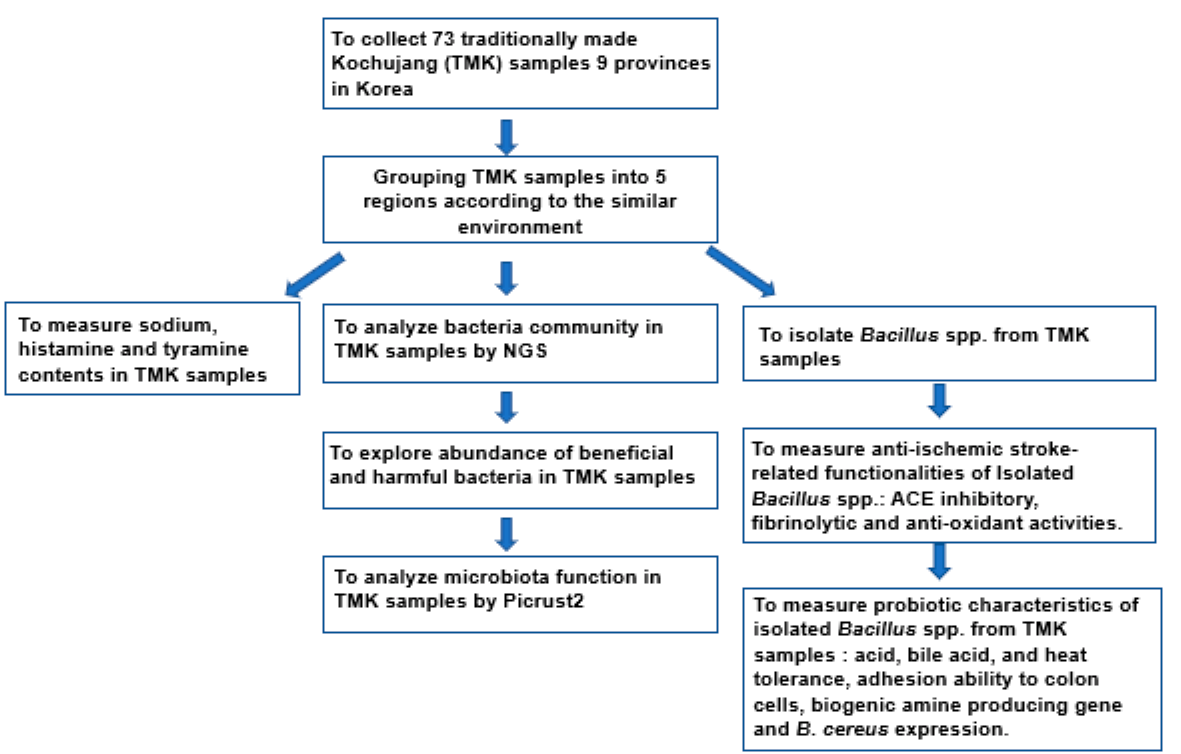
Figure 2. Scheme of the study design.